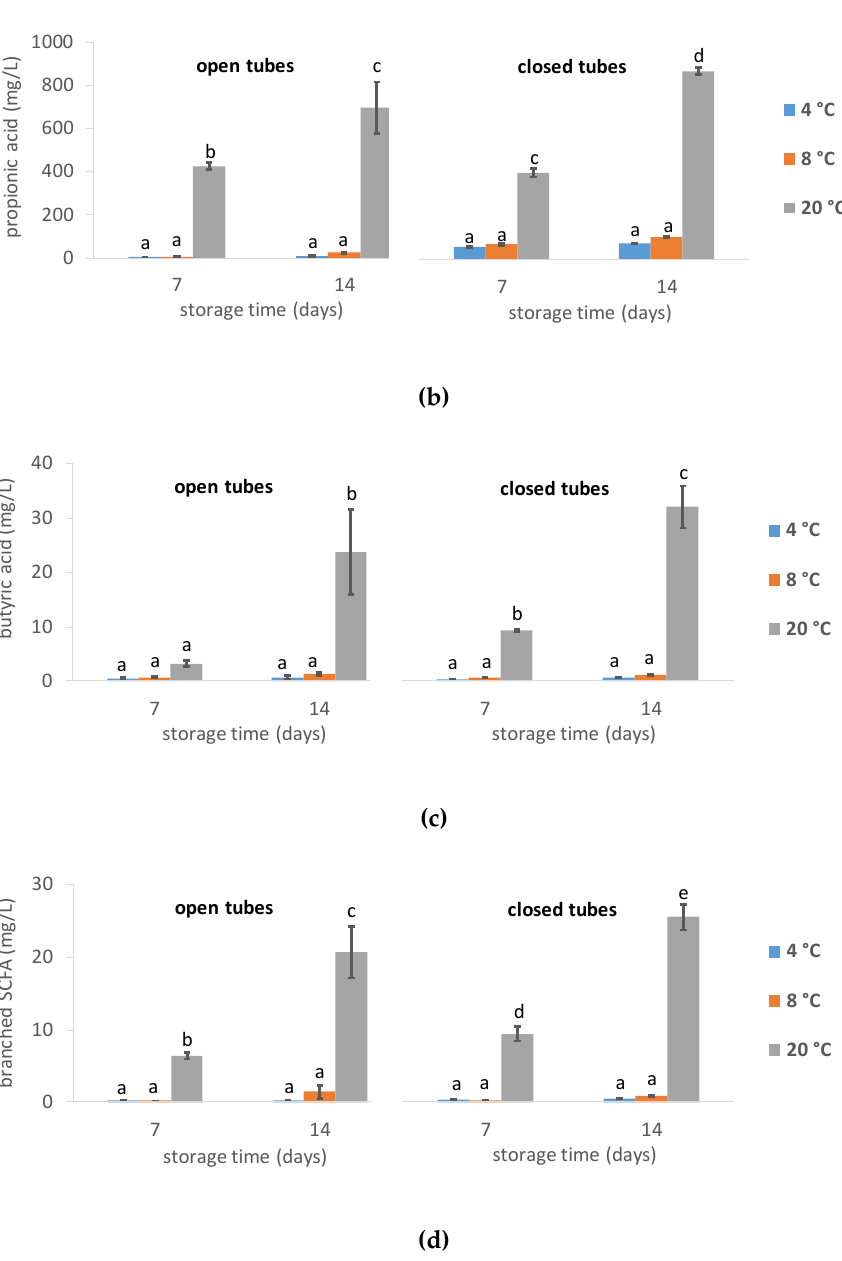
Figure 4. Short-chain fatty acid (SCFA) levels in algae concentrates to which no acetic acid was added—storage experiment 1. ( a ) Acetic acid concentrations, ( b ) propionic acid concentrations, ( c ) butyric acid concentrations and ( d ) concentrations of branched SCFA (sum of isobutyric and isovaleric acid) in algae concentrates to which no acetic acid was added. Separate graphs for isobutyric acid and isovaleric acid are included in Supplementary Materials Figure S3. Error bars represent standard deviations. Lowercase letters (a,b,c,d) denote significant differences. Values within one figure that are not labelled by the same letter are significantly different.